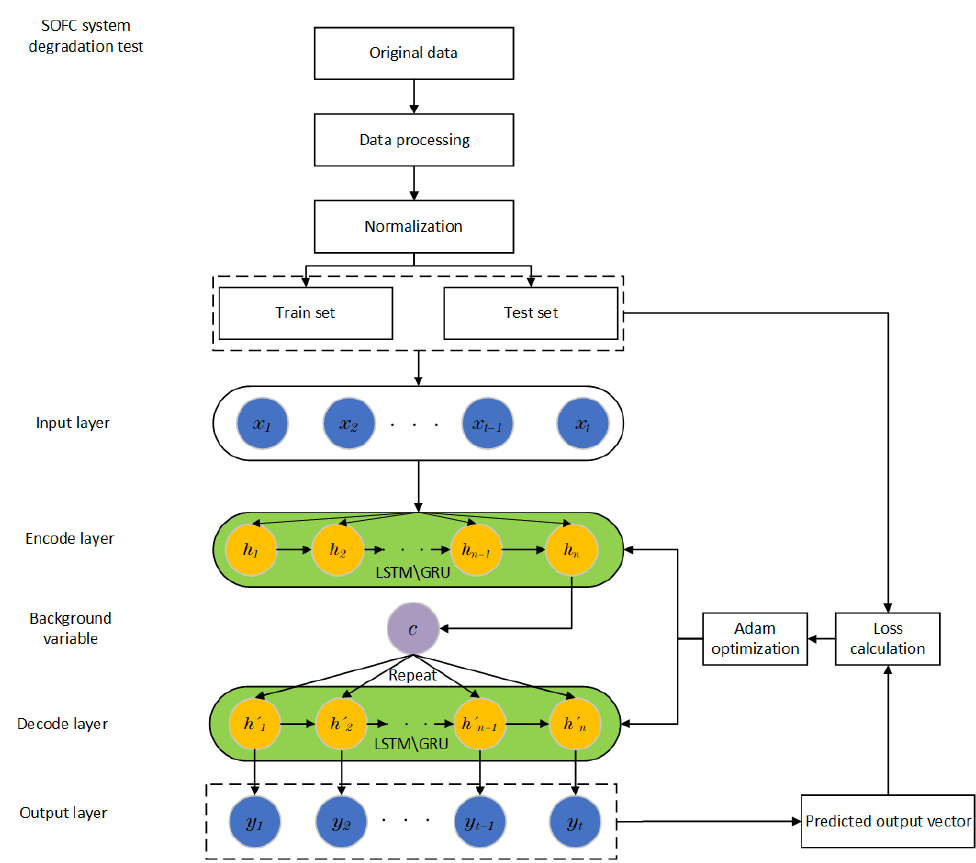
Figure 9. Structure of the encoder–decoder RNN model.